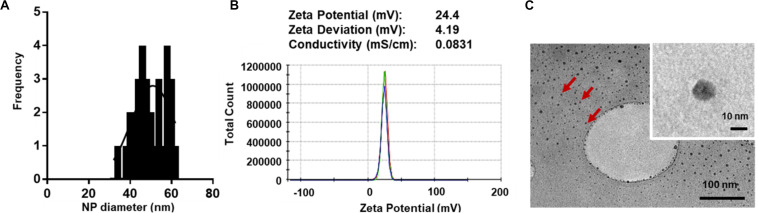
Characteristics of pDNA-PLL NPs. (A) NP size measured with Zetasizer Nano shows relatively small and homogenous distribution of NPs. (B) An image of a Zeta potential report indicates positive surface charge of NPs. The NPs were prepared and measured in nuclease free water; the same condition used for encapsulation in the double emulsion process. (C) TEM images demonstrate size and morphology of the same NPs. Red arrows highlight individual NPs.